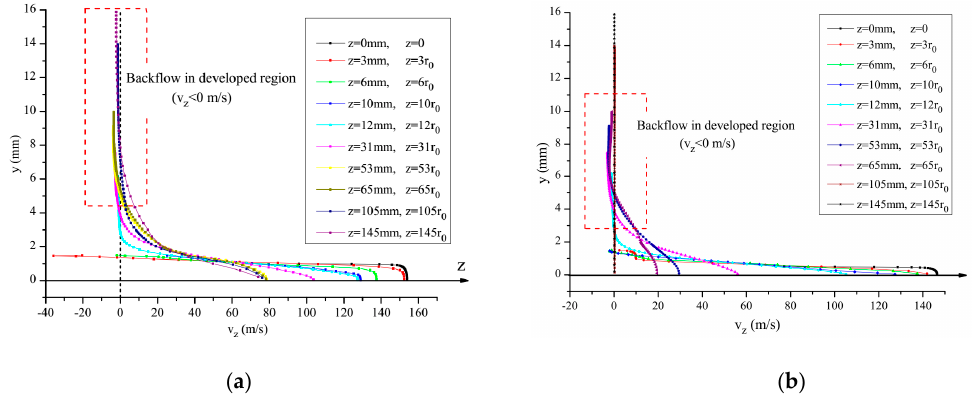
Figure 10. Schematic representation of the vertical section of the simulated. ( a ) L 0 = 2; ( b ) L 0 = 1.